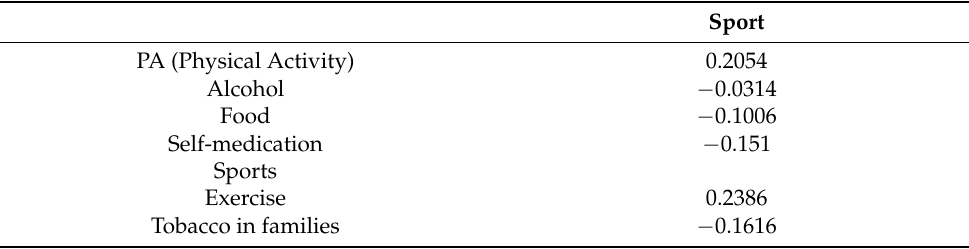
Table 4. The effects of the latent variables on